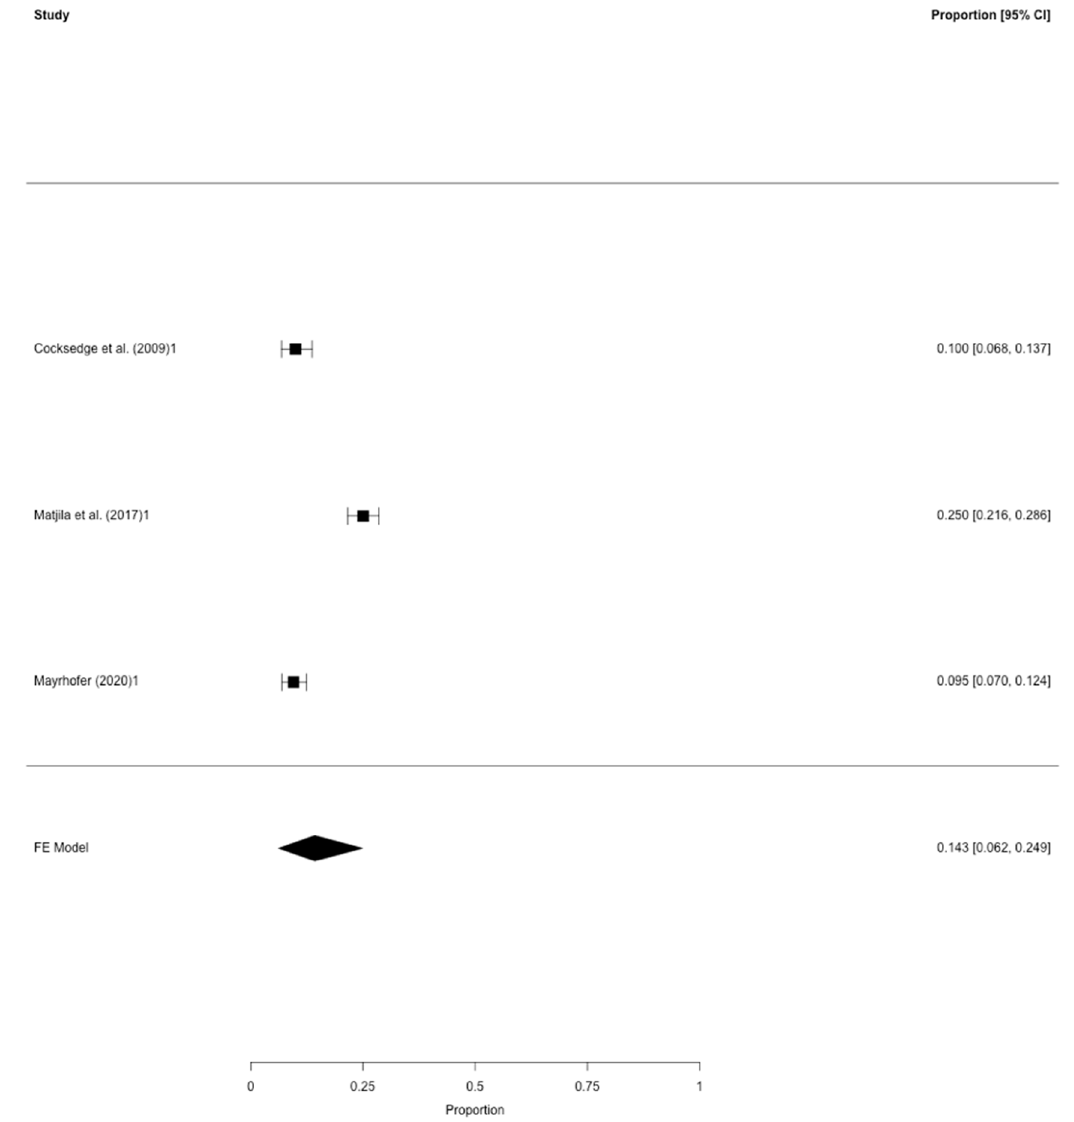
Figure 2. The prevalence of PCOS in RM. Meta-analysis of all three studies on PCOS (defined by Rotterdam criteria) in patients with RM ( ≥ 3 consecutive miscarriages before gestation week 20). Provided are the proportions including the 95% confidence intervals.